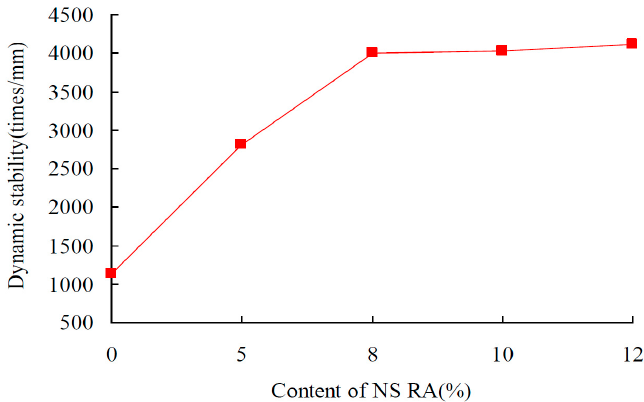
Figure 5. Dynamic stability of modified asphalt mixtures with different NS RA contents.